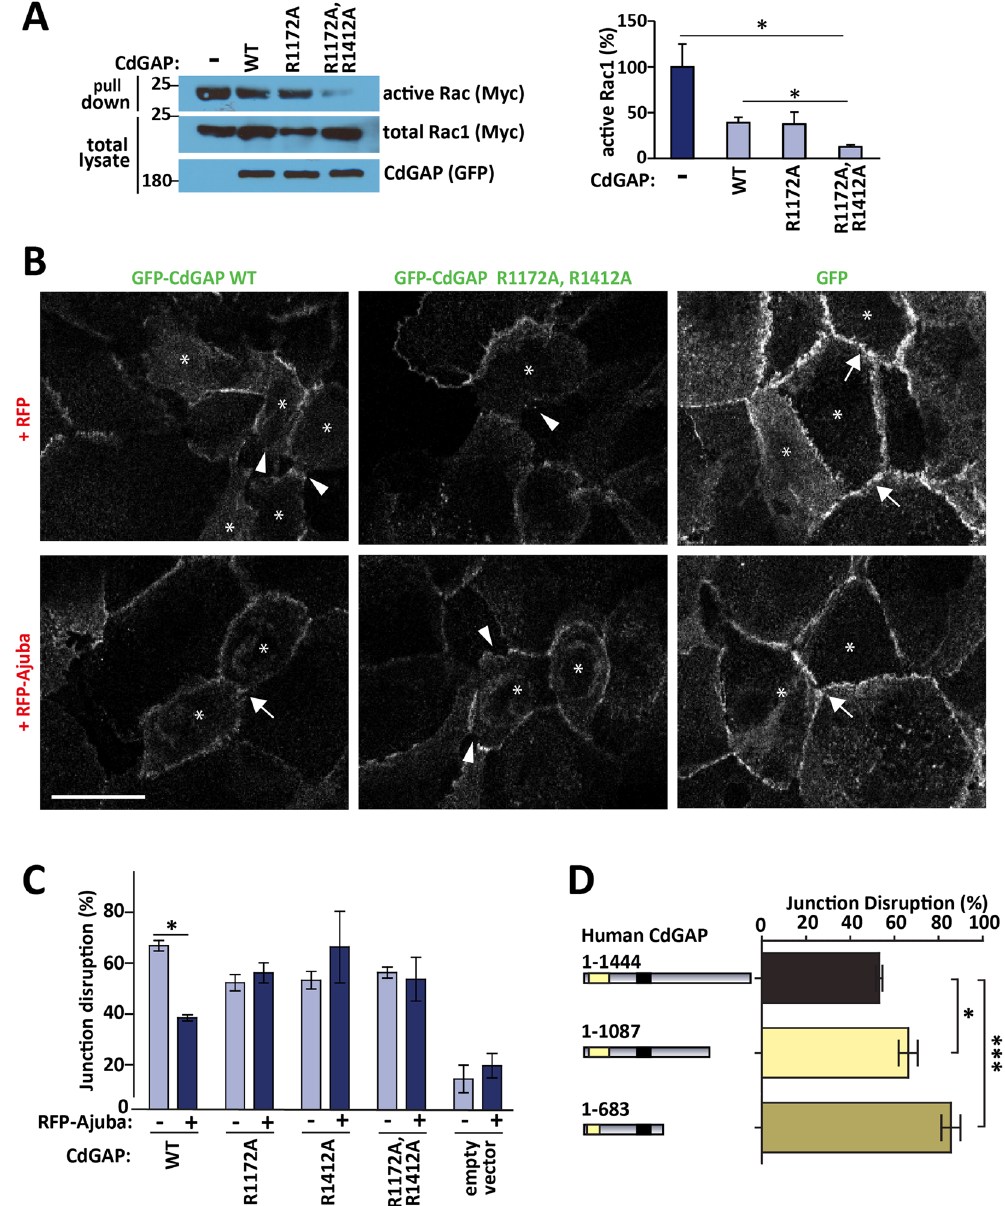
Figure 6. Ajuba regulates CdGAP activity. ( A ) Cells were co-transfected with myc-tagged wild-type Rac1 and GFP-tagged constructs of CdGAP wild-type (WT) or mutants with deficient Ajuba binding (R1172A and R1172A/R1412A). Lysates were prepared and incubated with GST-PAK-CRIB to detect active Rac1 (pull down). Total cell lysate shows levels of expressed proteins. ( B ) Keratinocytes with mature junctions were transfected with GFP-CdGAP wild-type or CdGAP mutant deficient in Ajuba binding, in the presence or absence of RFP- Ajuba for 24 hours. Cells were fixed and stained for E-cadherin. Images were collected on a confocal microscope (see also Figure S4). Arrows indicate junctions with continuous E-cadherin staining (arrows) or disrupted junctions with partial loss of E-cadherin (arrowheads). ( C ) The number of cells with highly disrupted junctions (defined as more than two holes between neighbouring cells) was counted for each condition. ( D ) Wild-type and truncation mutants of human CdGAP found in AOS patients were expressed in keratinocytes. The number of disrupted junctions was quantified as above. Scale bar = 25 µ m. Statistical significance was assessed using two-way ANOVA ( C ) or one-way ANOVA ( A , D ). * P ≤ 0.05; *** P ≤ 0.001. N = 3 ( A , D ), N = 2 ( C